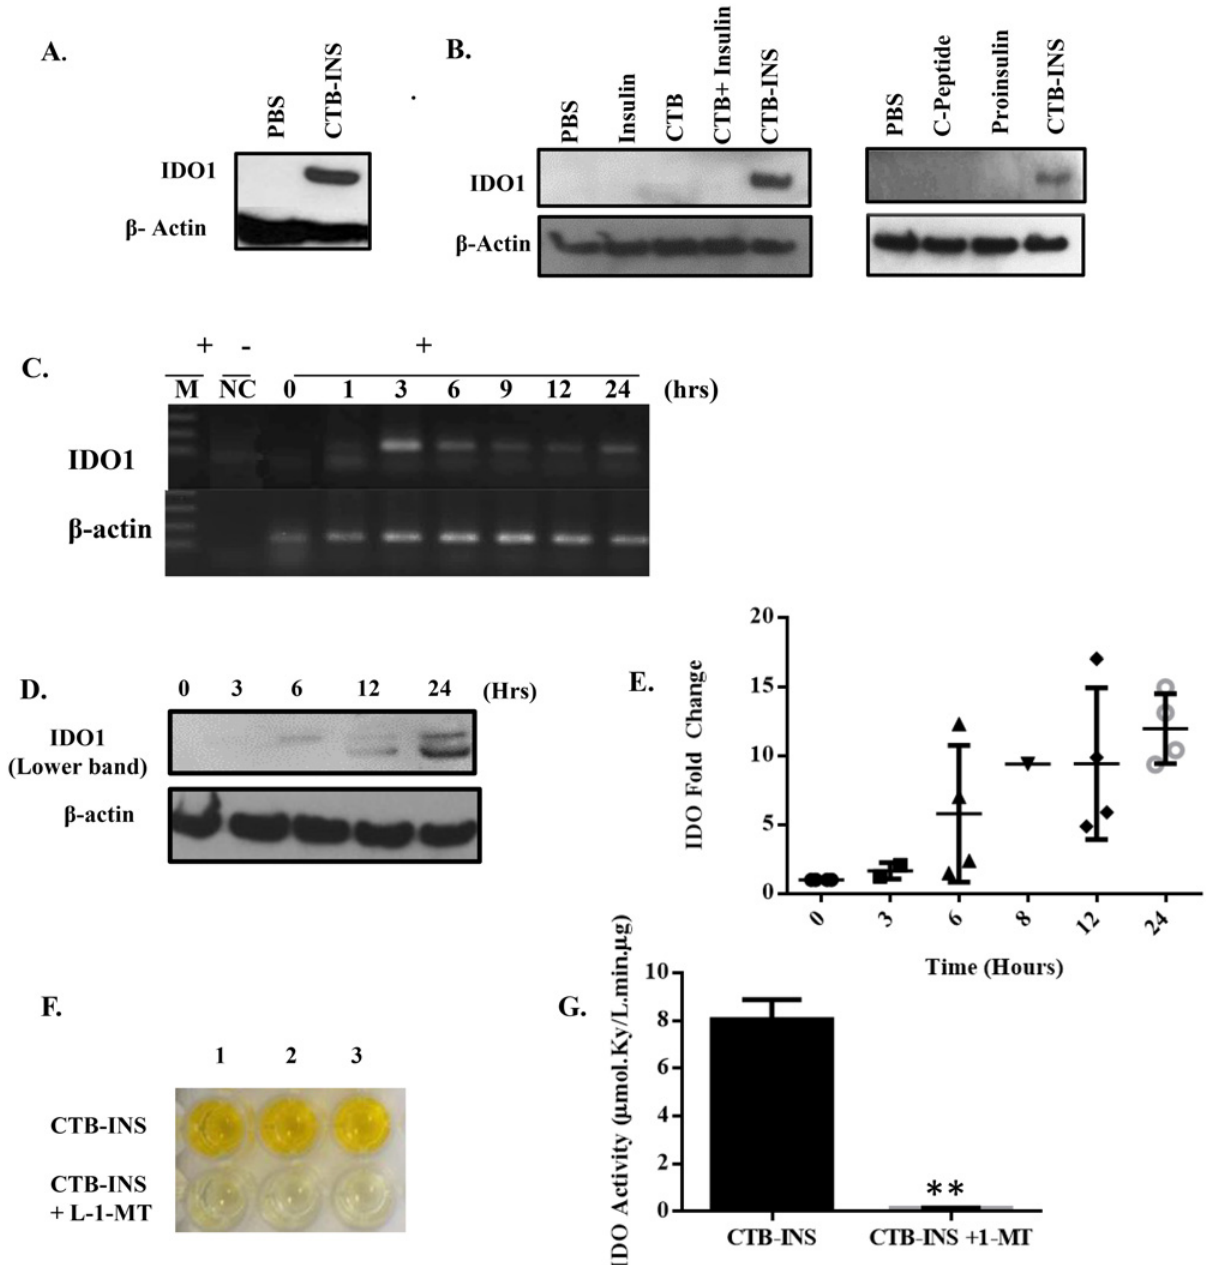
Fig 3. Vaccine induction of IDO1 biosynthesis in dendritic cells. (A) Immunoblot detection of IDO1 protein synthesis in human DCs in the presence of CTB-INS. (B) Immunoblot analysis of IDO1 up-regulation in DCs inoculated with all components of the CTB-INS fusion protein including insulin C-peptide. The images are representative of five subjects. (C) Reverse transcriptase polymerase chain reaction (RT-PCR) for assessment of IDO1 mRNA expression in a time dependent manner from DCs incubated with and without CTB-INS. RNA (2 μ g). The cDNA samples were used as templates for PCR amplification. The DNA amplification products were visualized on X ray film after electrophoresis in 2.0% agarose gels. Lane M : 100 bps DNA ladder marker ( Gibco ); lane NC : negative control RNA after treatment with DNase I from DCs as template; lane 0 : cDNA from DCs without CTB-INS inoculation (-); lanes 1 , 3 , 6 , 9 , 12 and 24 : cDNA from time-dependent DCs incubated with CTB-INS (+). A β -actin gene was used as an internal standard in RT-PCR.The image is representative of 3 different subjects. (D, E) Immunoblot of a time course of IDO1 expression in DCs after inoculation with CTB-INS (10 μ g/mL). Cell samples were harvested at 0, 3, 6, 8, 12 and 24 hours after vaccine inoculation. The data is representative of 6 different subject samples. (Shapes on Panel E represent different subjects). (F, G) Assessment of vaccine induced IDO1 activity and L-1-methyl-L-tryptophan (L-1-MT) inhibition of IDO1 activity in vaccinated DCs identified by ELISA. Top wells in the plate (F), show the production of tryptophan degradation products (kynurenines) in vaccinated DCs. Bottom wells show the inhibition of IDO1 kynurenine biosynthesis (absence of yellow color), in vaccinated DCs treated with L-1-MT (bottom wells). The data was compared for significance using a paired t-test, p =